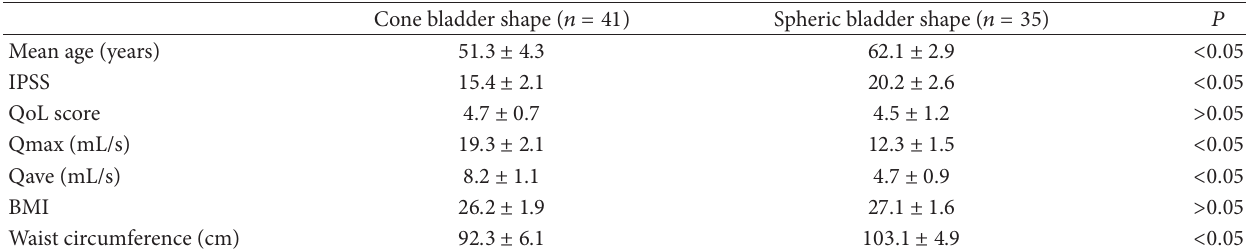
Table 1: Patients’ characteristics in groups 1 and 2.